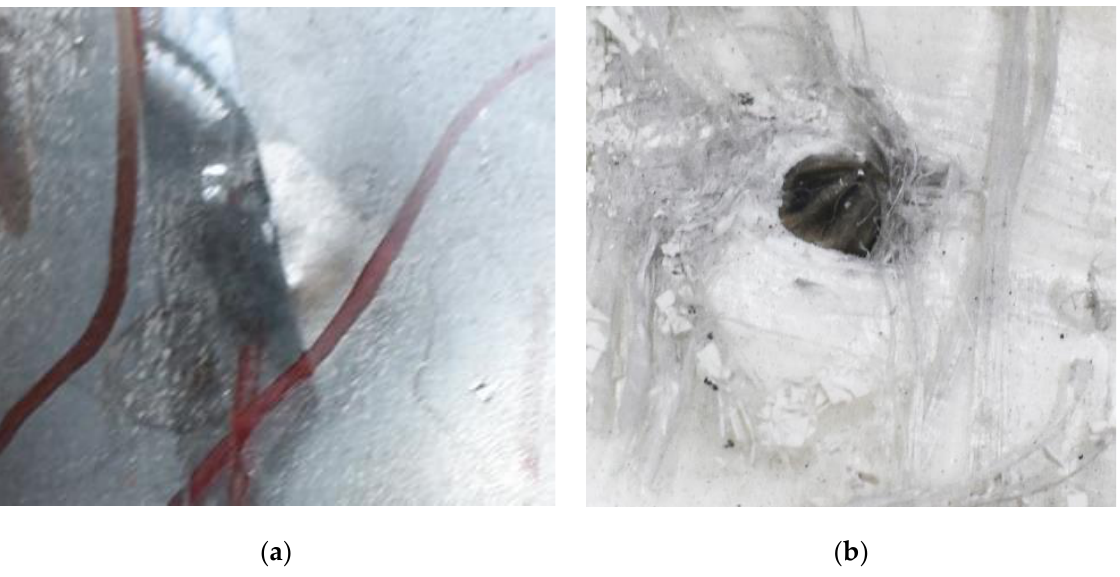
Figure 9. Additional details for the perforation results at the impact velocity of 433.3 m/s. ( a ) Inden- tation of back plate by penetration. ( b ) Embedded penetrator.